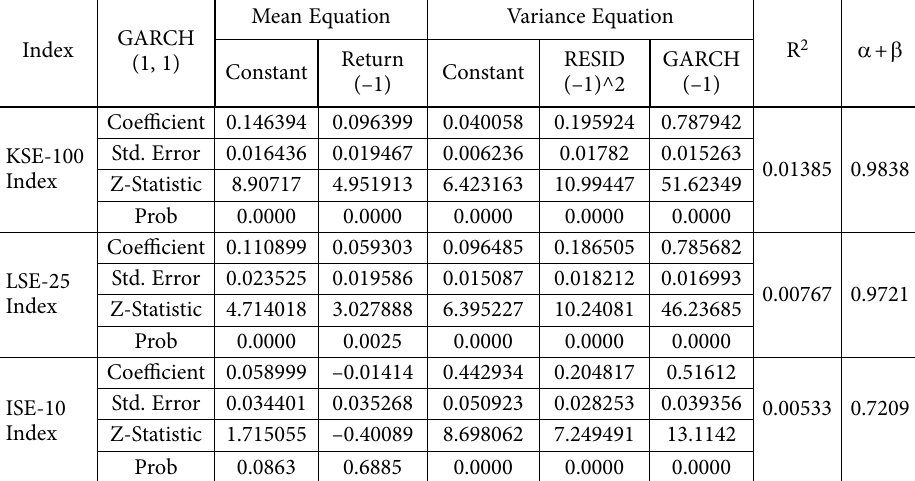
Table 4. Mean reversion in stock indices (source: authors’